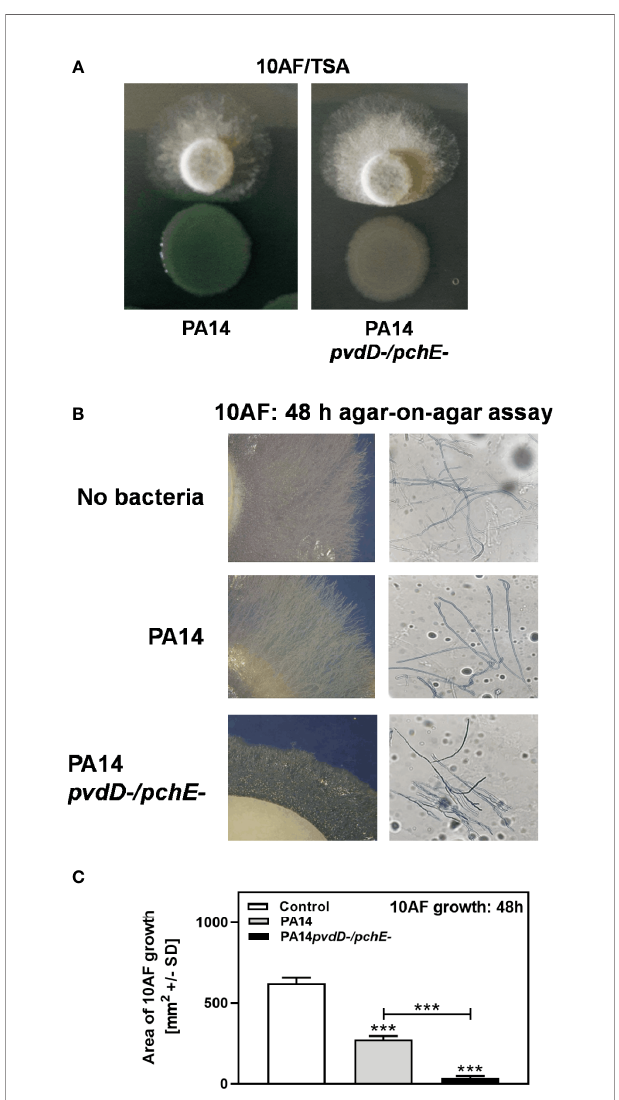
FIGURE 1 | Under coculture conditions on agar, a P. aeruginosa PA14 mutant lacking both major siderophores is more virulent for A. fumigatus than its wild type. (A) Six-millimeter paper disks were placed on RPMI agar. Ten microliters of A. fumigatus 10AF conidia (10 7 /ml, prepared in RPMI) was placed on each disk, and 10 µl of PA14 wild type or PA14 pvdD-/pchE- bacteria (10 9 /ml, prepared in RPMI) was placed 15 mm distant from the disks carrying 10AF. Plates were incubated for 48 h at 37°C, and growth quotients were determined. (B, C) A piece of RPMI agar (5.5 cm) was placed on an RPMI agar plate (10 cm). Ten microliters of P. aeruginosa bacterial suspension (10 9 bacteria/ml) or RPMI was distributed on the top RPMI agar piece. Plates were incubated at 37°C for 48 h. After incubation, plates were centrifuged at 1,000 rpm for 10 min. The top agar piece was removed and replaced by three 6-mm paper disks. Ten microliters A. fumigatus suspension (10 7 conidia/ml) was inoculated on each disk. The plates were incubated at 37°C for 48 h, representative pictures were taken (B) , and the areas of A. fumigatus growth were calculated and are summarized in (C) The right part of (B) is a magni fi cation of the left part. Agar, primed with PA14 pvdD-/pchE- , allowed less A. fumigatus growth and more hyphal branching, compared to agar primed with PA14 or agar that did not carry bacteria. Comparison in (C) : RPMI vs . all other bars, or as indicated by the ends of the bracket. Statistical analysis, t-test: Three asterisks = p ≤